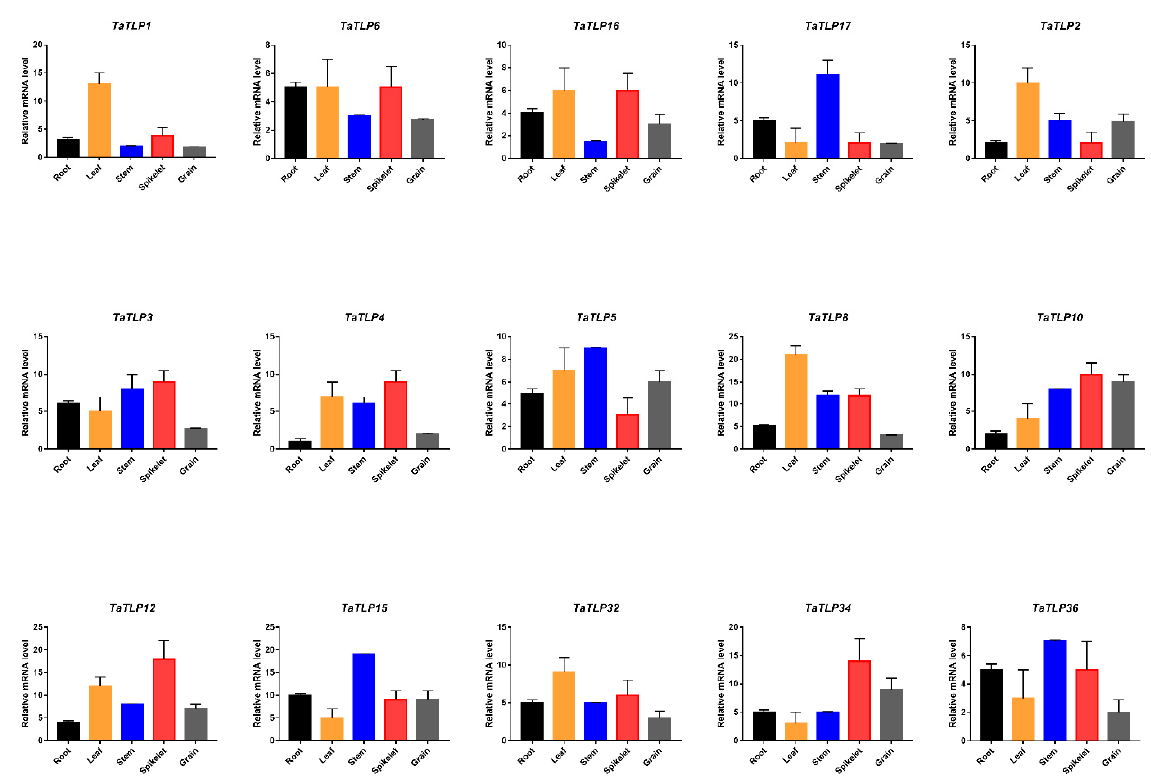
Figure 10. Expression analysis of TaTLP genes in different tissues of wheat.